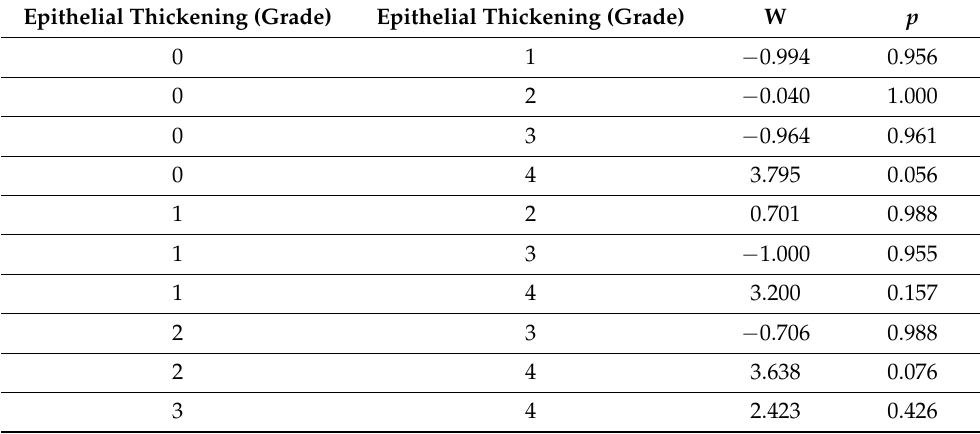
Table 10. Dwass–Steel–Critchlow–Fligner pairwise comparisons (intensity ratio) for the variable “epithelial thickening” after the statistically significant kruskal-Wallis test. Column 1 and Column 2 represent the paired epithelial thickening grades in comparison.